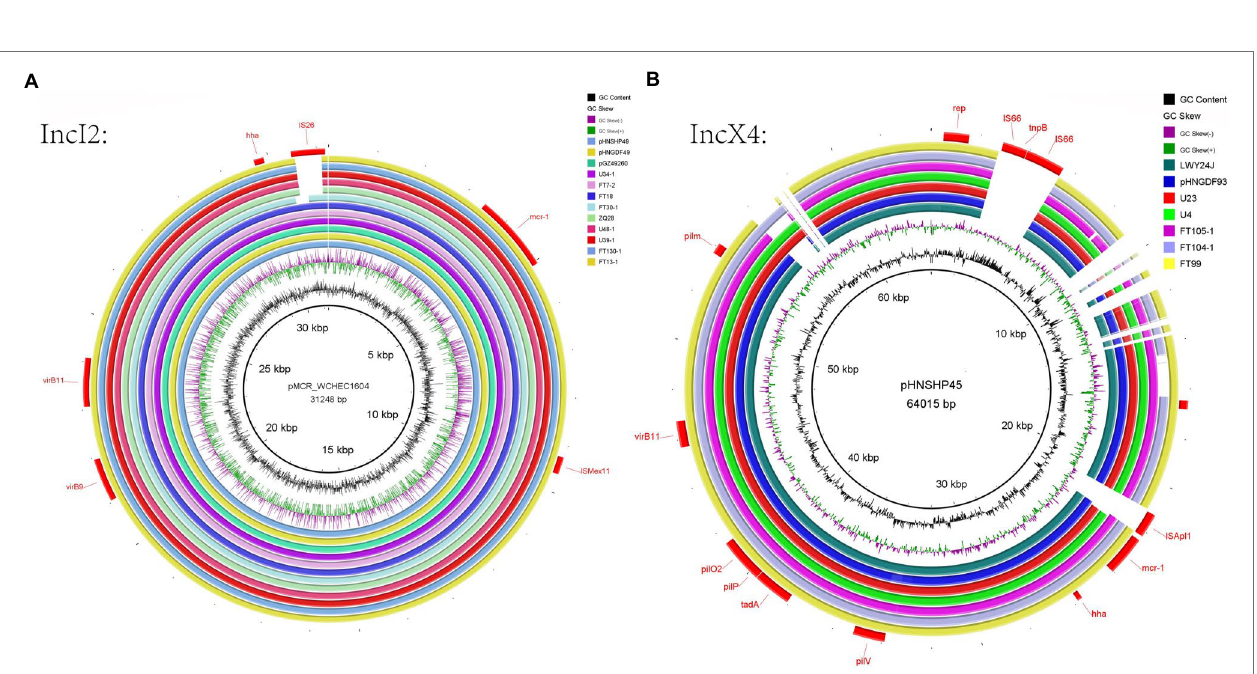
FIGURE 1 | Analysis of MCRPE isolates used in this study. Left Panel: Isolates from migratory birds in Guangdong, China (black font) and from the NCBI database (red font). Right Panel: Genetic relationships among 32 mcr-1 positive Escherichia coli (MCRPEC) isolates using a maximum likelihood tree. Red-filled squares indicate possession of the indicated antibiotic resistance genes (ARG) and blue-filled squares indicated plasmid Inc type.